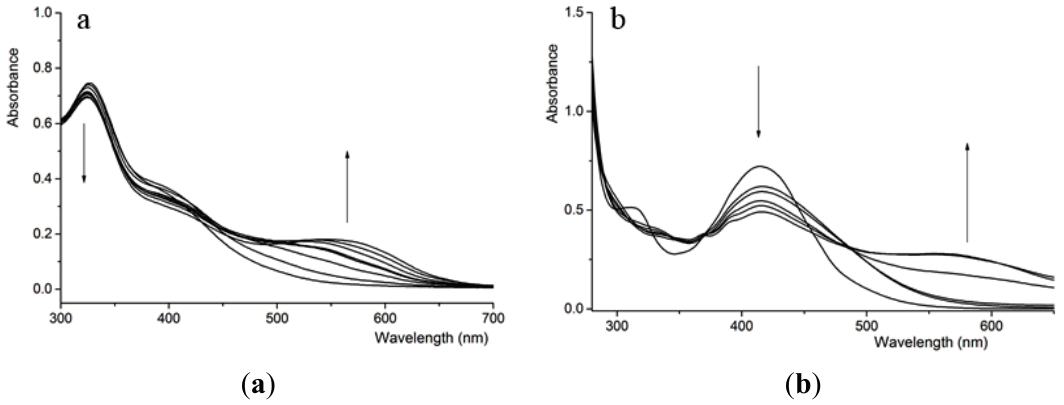
Figure 1. UV-Vis spectral changes of compounds (4.0 × 10 − 5 mol·L − 1 ) in DMSO upon addition of AcO − (0–50 equiv), ( a ) 1 ; ( b ) 3 . The arrow indicates the direction of increase of acetate